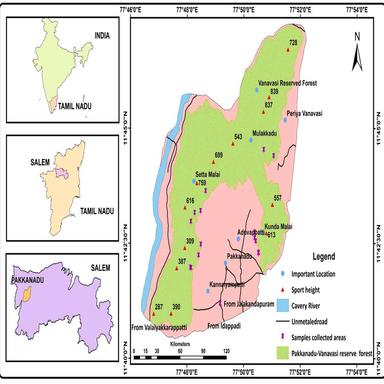
Study area map.